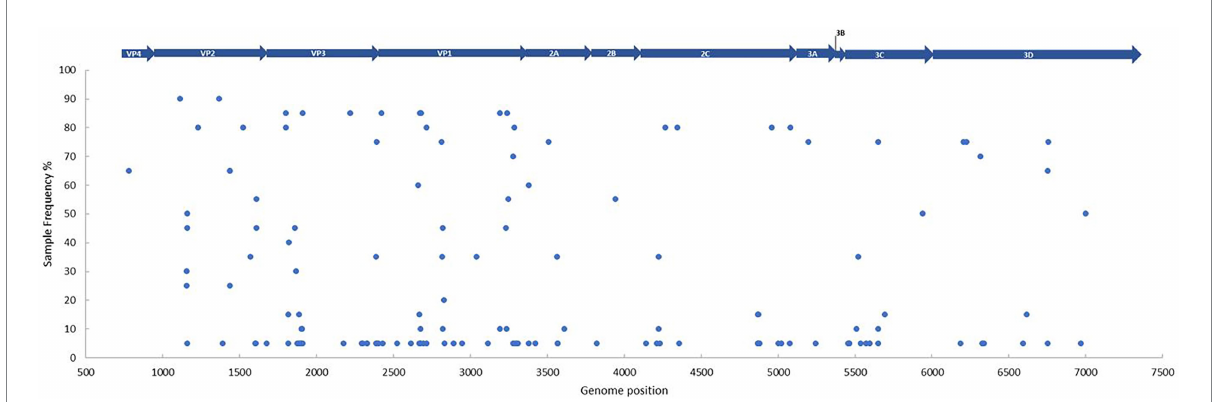
FIGURE 3 The frequency and distribution of single nucleotide variants per genome position between the patient samples ( n = 20) and the Fermon strain (accession number AY426531). Every blue dot represents a non-synonymous change on the sequence, with the gene position depicted above. Sample frequency denotes the percentage of samples in the data set with the non-synonymous change. A Fixed Ploidy algorithm was applied on CLC Genomics Server v21.0.5 using the following parameters: 90% variant probability, 90% minimum frequency, min 100x coverage, max 100,000x coverage, Q-score threshold =